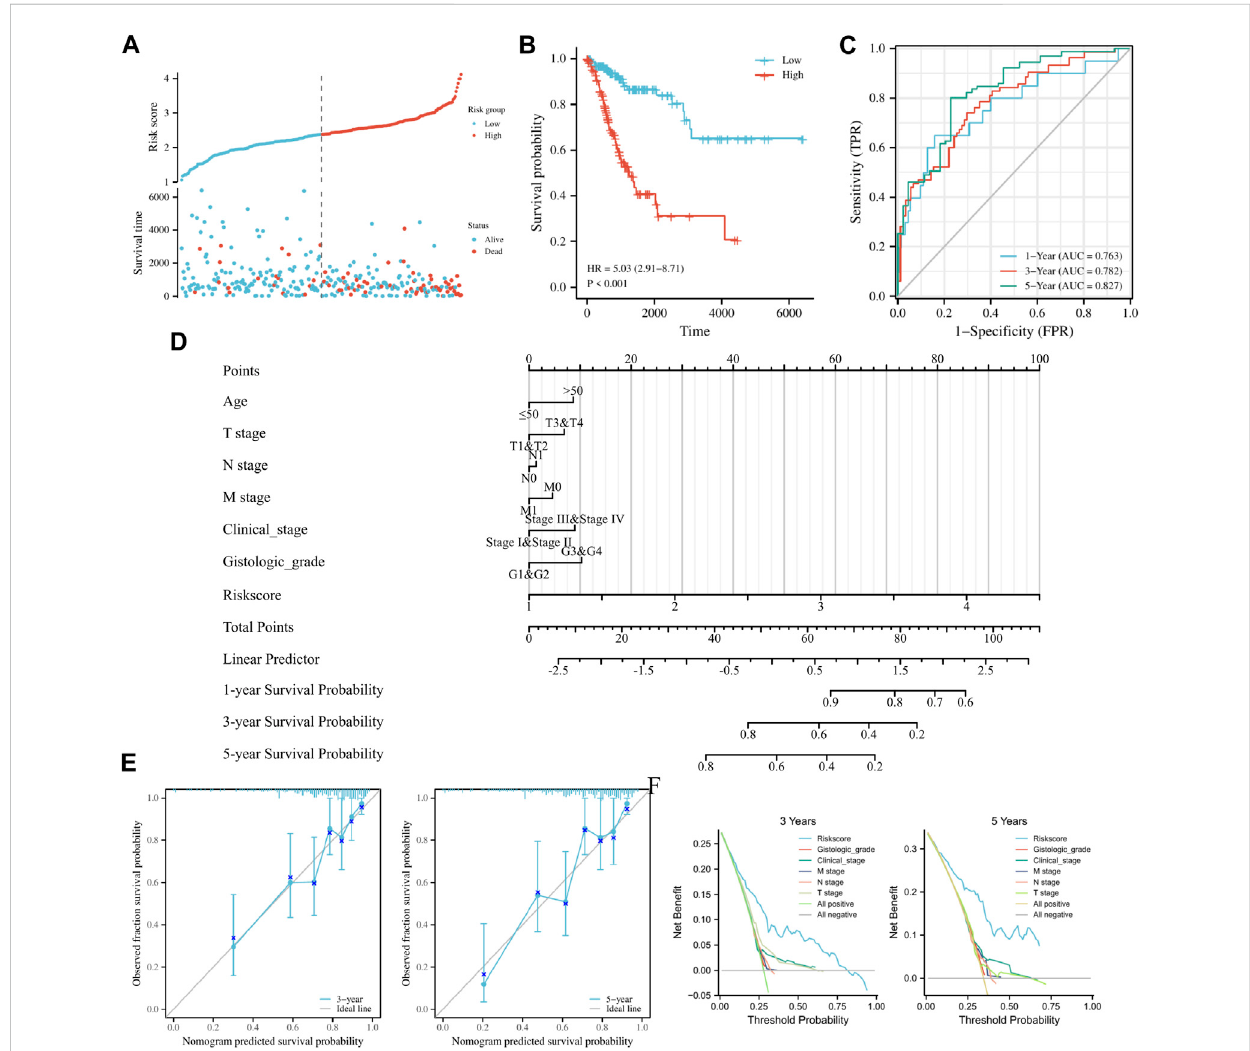
FIGURE 2 Establishment and prognostic analysis of FRGs prognostic model in cervical cancer . (A) Curve scatter plot of training set survival model ef fi cacy assessment and cumulative scatter plot of survival mortality event risk. (B) KM curves show a signi fi cant difference in OS between high-risk and low-risk groups in the training set. (C) Time-dependent ROC curves were used to predict 1, 3 and 5 years survival. (D) 1, 3, and 5 years nomograms for predicting OSincervicalcancer. (E) Calibrationcurvesshowingtheagreementbetweenpredictedandobserved3and5yearsOS. (F) Decisioncurveanalysisof the prognostic model in the training set at 3 and 5